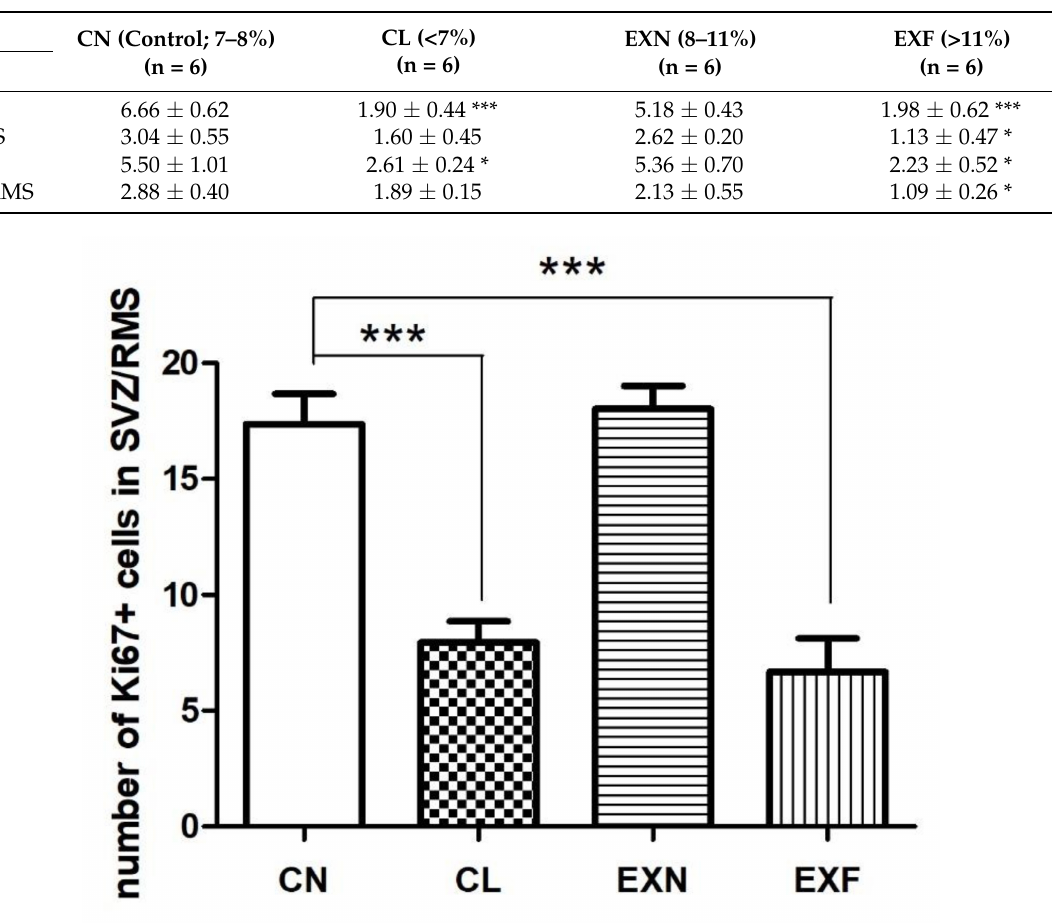
Figure 3. The total number of Ki-67+ cells in the SZV/RMS neurogenic region in mice with various body conditions. Abbreviations: SVZ—subventricular zone; RMS—rostral migratory stream; (CN) control group of mice characterized by normal weight and physiological percentage of body fat deposits; (CL) control group of mice characterized by reduced weight and reduced body fat deposits; (EXN) experimental group of mice characterized by normal weight and moderately elevated body